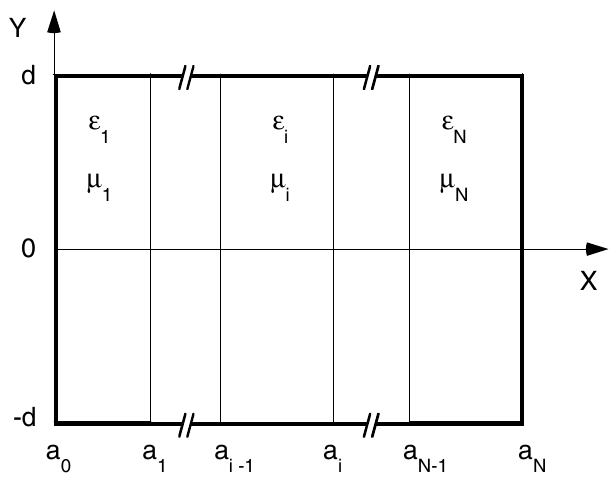
FIG. 7. Cross section of an N -zone dielectric-lined rectangular waveguide